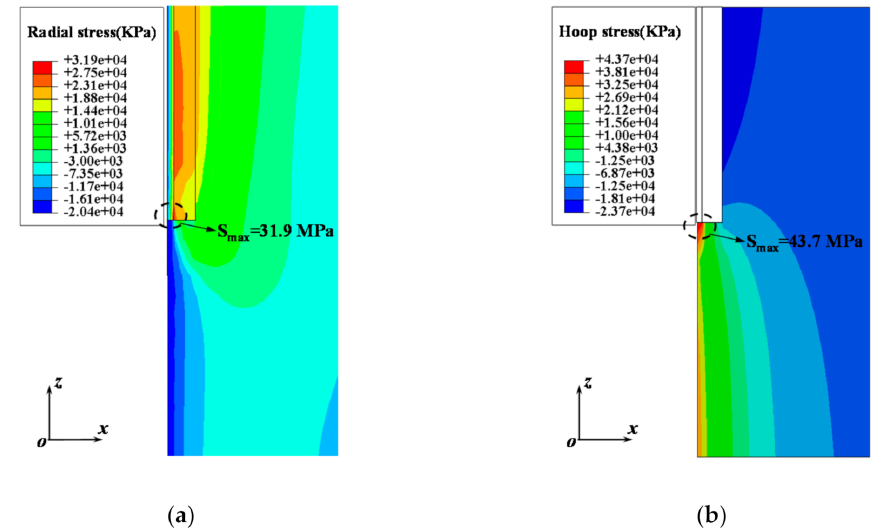
Figure 7. Local stress distribution: ( a ) Local radial stress distribution of the casing–cement sheath– formations interface; ( b ) local hoop stress distribution of the formations.